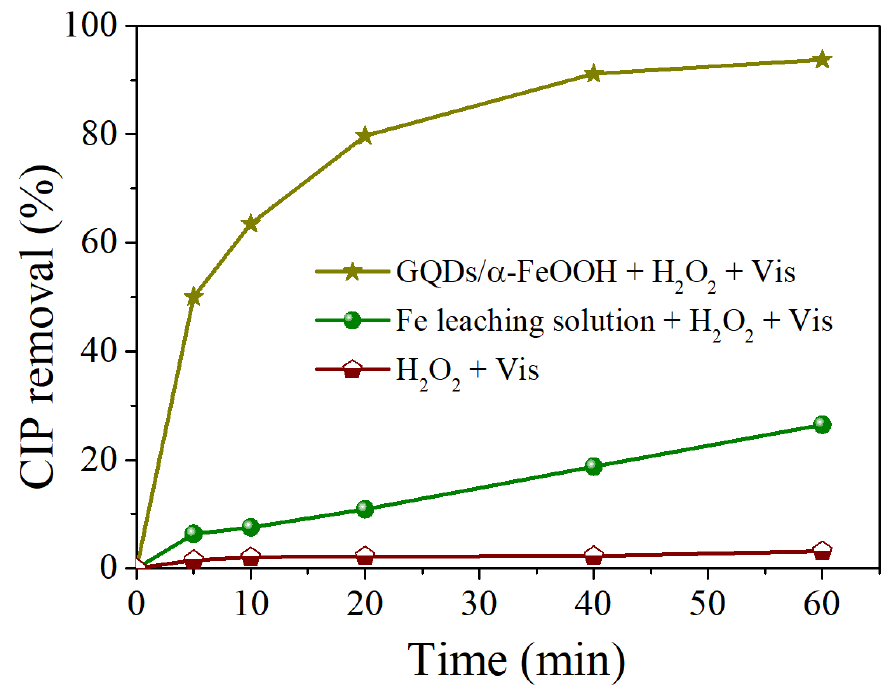
Figure 7. The contribution of homogeneous photo-Fenton reaction in GQDs/ α -FeOOH + H 2 O 2 + Vis